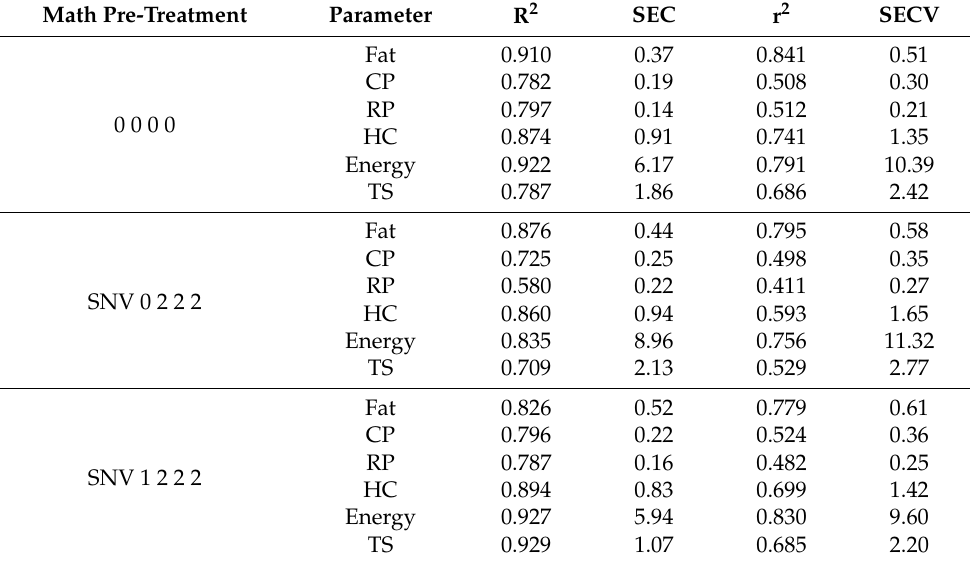
Table 2. Calibration and cross-validation statistics for breast milk samples using partial least squares